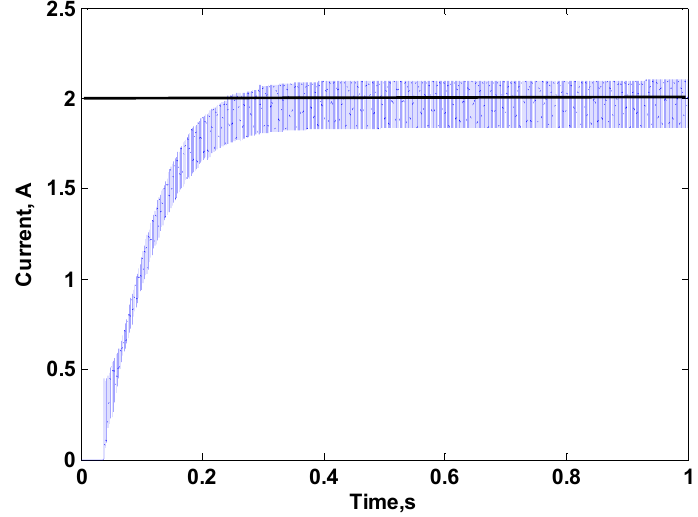
Figure 22. Charging current at a reference current of 2 A.